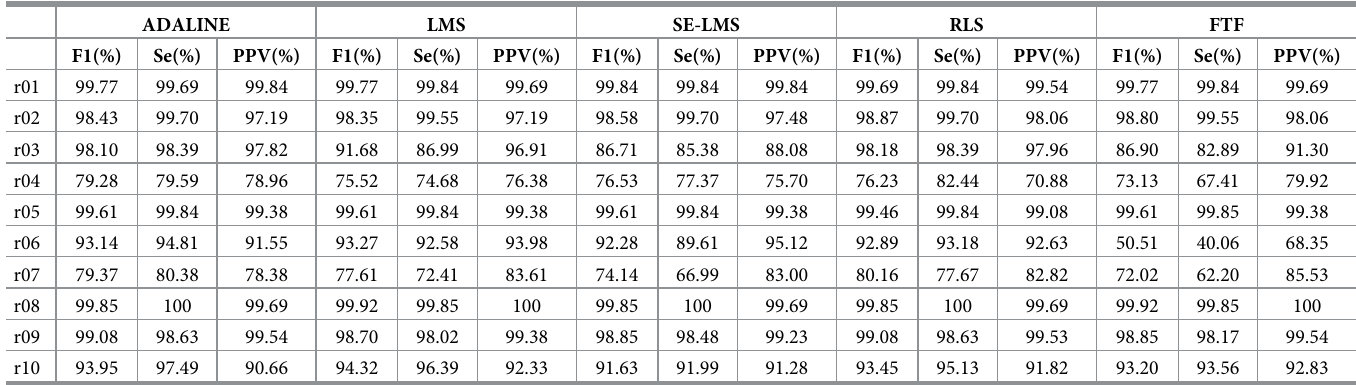
Table 3. Results of the experiments on dataset